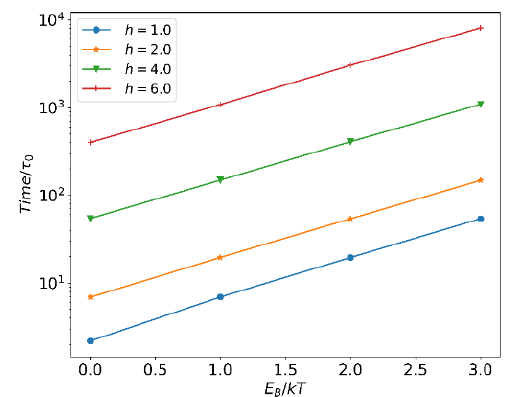
Figure 2. Dependence of the reversible bond life time τ b on E B